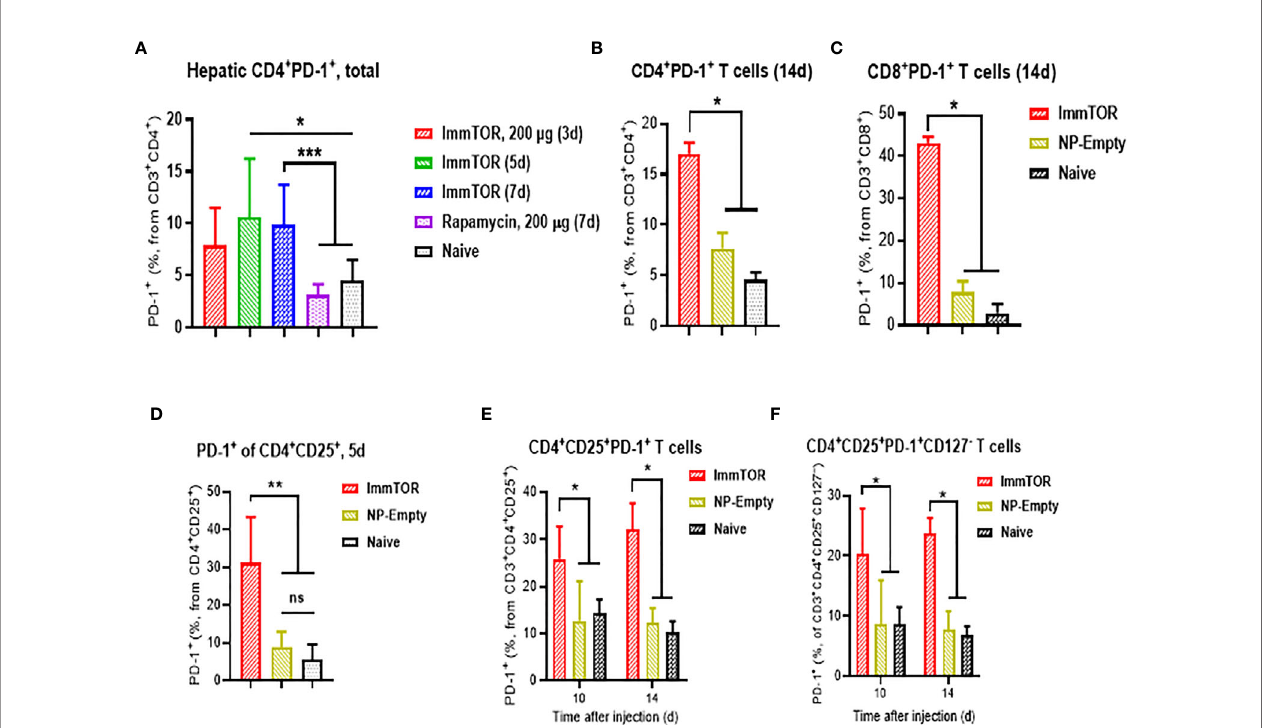
FIGURE 5 | ImmTOR treatment leads to upregulation of PD-1 expression on hepatic T cells and regulatory T cells. T cells were directly stained in liver cell suspensions and analyzed after i.v. injection of ImmTOR at 200-400 µg or the same dose of free rapamycin or NP-Empty. Fractions of PD-1+ hepatic T helpers or CTL (identi fi ed as CD3 + CD4 + or CD3 + CD8 + , correspondingly) is shown (A – C) as well as fractions of PD-1 + T effectors (D, E) , identi fi ed as CD3 + CD4 + CD25 + ) and ‘ classic ’ Tregs (F) , CD3 + CD4 + CD25 + CD127 – ). Summaries of three (A) or two (D) independent experiments are shown (n=4-13 or 4-9 mice/group, respectively), or representative results of individual studies (n=3-5 mice/group) repeated at least twice (B, C, E, F) . Data shown in (A) result from analysis of different and overlapping time-points. Statistical difference in the size of respective fractions from ImmTOR-treated animals vs. that in naïve mice or those treated with NP-Empty or free rapamycin is shown (* – p<0.05, ** – p<0.01, *** – p<0.001; Mann-Whitney test). ns, not signi fi